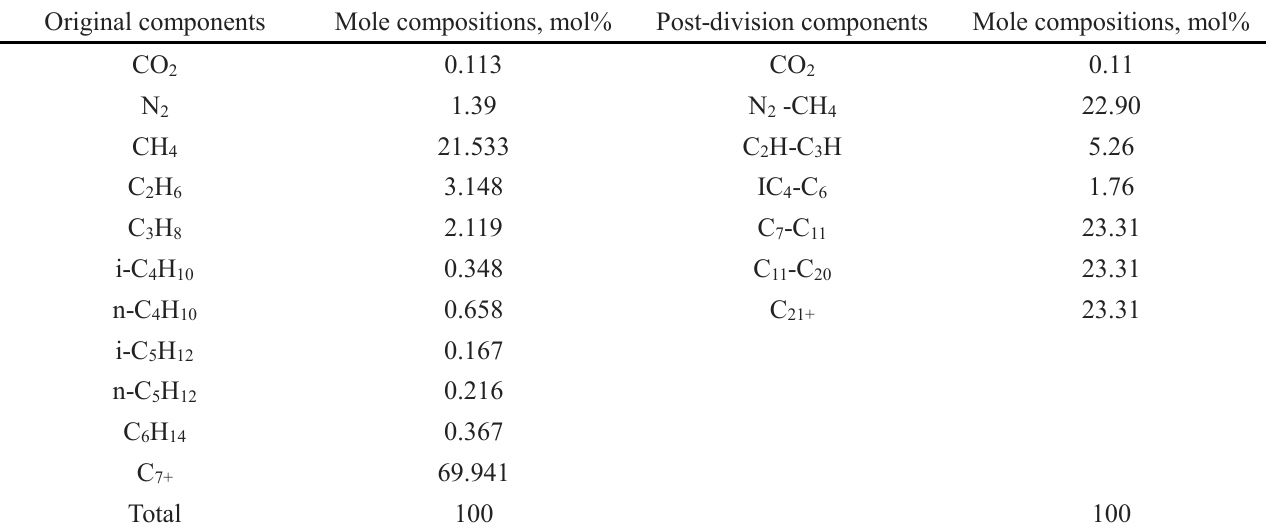
Table 1—Pseudo-components of fluids in low-permeability